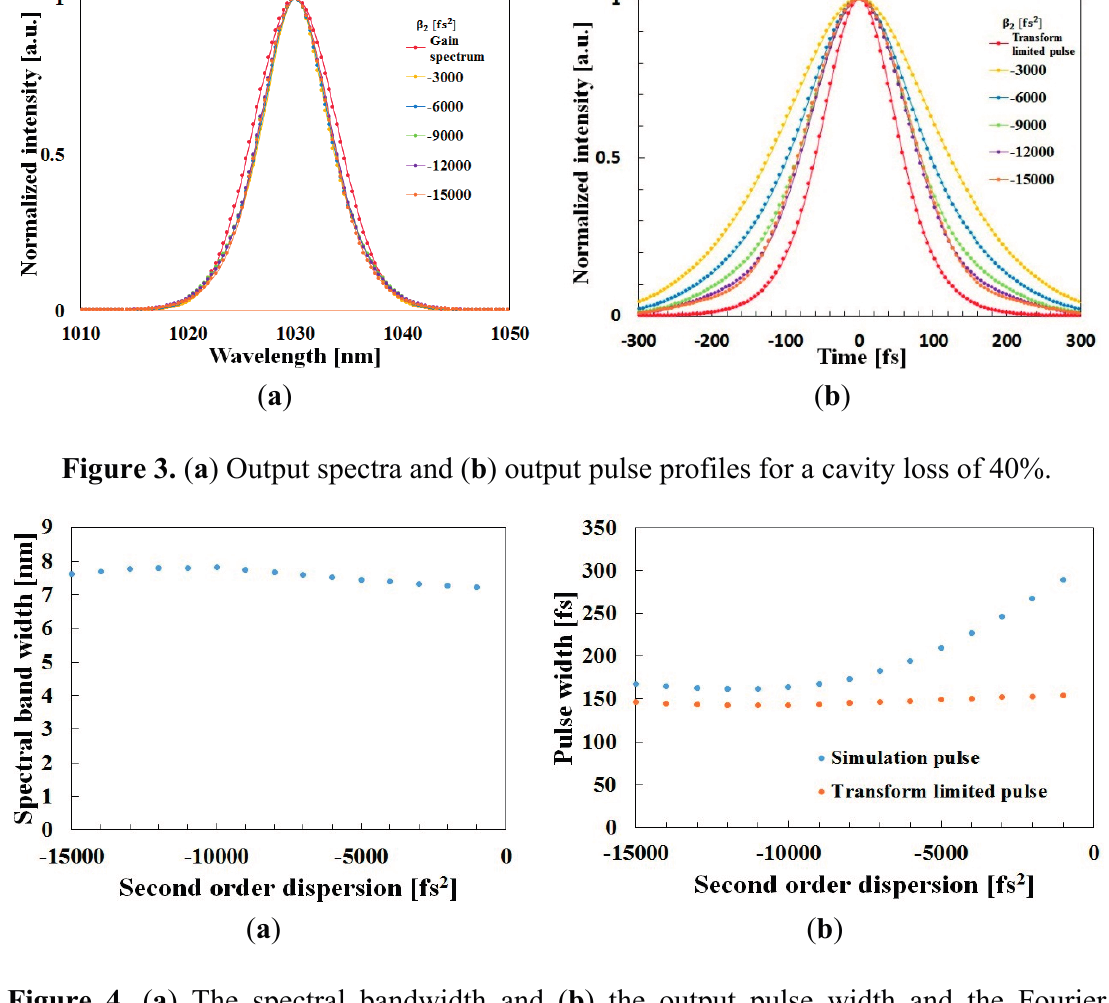
Figure 4. ( a ) The spectral bandwidth and ( b ) the output pulse width and the Fourier transform-limited pulse width of the corresponding output spectrum as a function of SOD for a cavity loss of